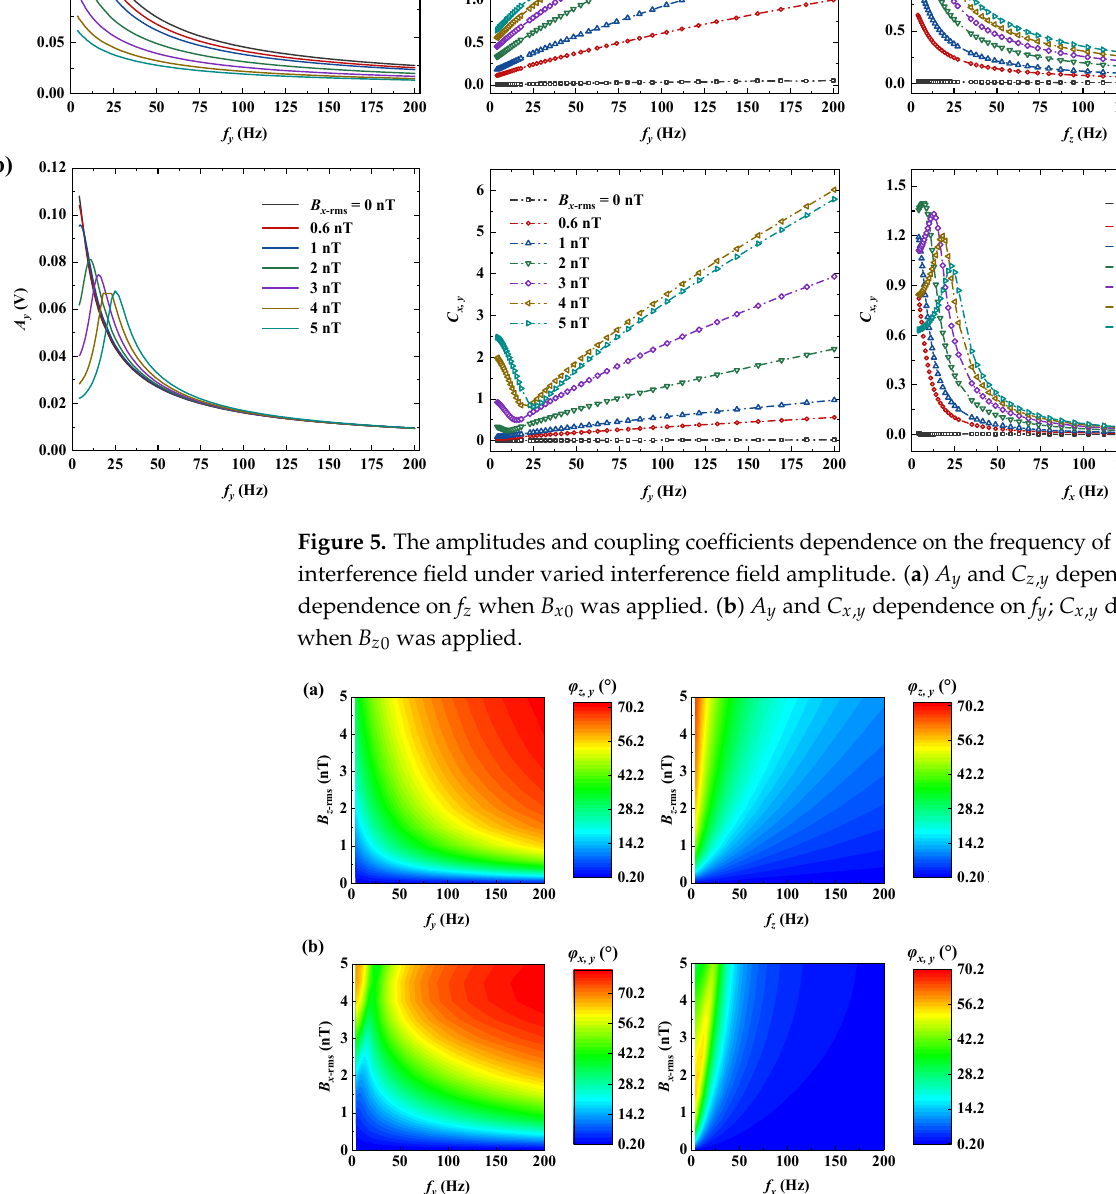
Figure 6. The tilting degree dependence on the frequency of the sensitive and interference field under varied interference field amplitude. ( a ) φ z, y dependence on f y and f z when B x 0 was applied. ( b ) φ x, y dependence on f y and f x when B z 0 was applied.